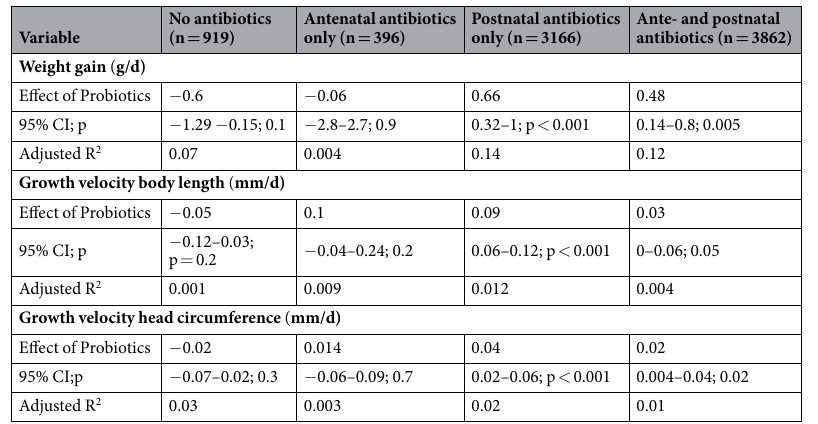
Table 6. Effect of probiotics on growth during primary stay in hospital. Linear regression analysis included gestational age per week, birth weight in 100 g steps, gender, multiple birth, maternal descent and exposure to Bifidobacterium infantis / Lactobacillus acidophilus probiotics. The effect of probiotics on weight gain as g/d growth rates in mm/d is shown as B coefficient, 95% confidence interval and p-value. Adjusted R 2 values indicate coefficients of determinations and adjust for the number of terms used in the